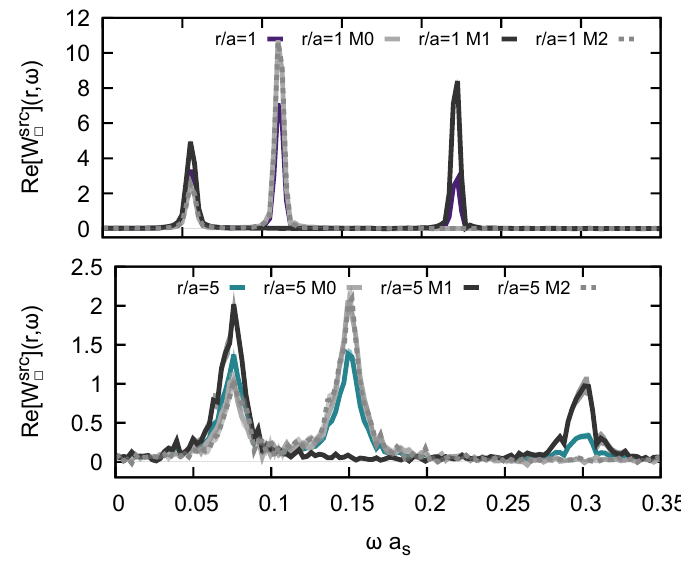
Figure 10 . Comparison of the spectral function of the Wilson loop trace h W i (solid) in coordinate space to the modified traces h M i W i (gray symbols) at the shortest distance r/a = 1 (top) and an intermediate distance r/a = 5 (bottom). We find that while they do show differences in behavior at the higher lying frequencies, all modified traces exhibit a lowest lying peak at the same